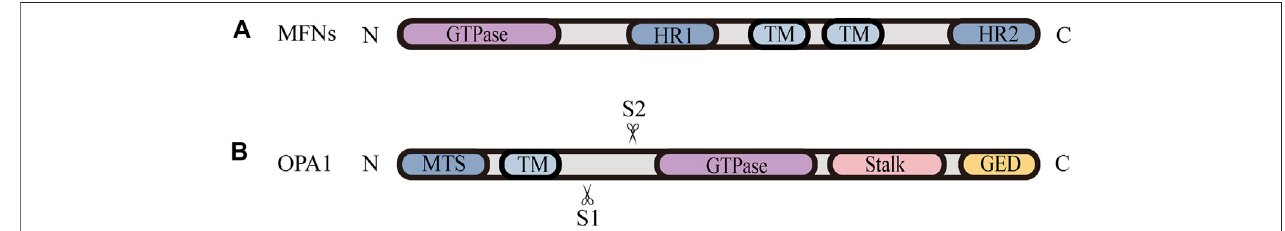
FIGURE 2 | Schematic diagrams of the structural elements of fusion proteins. (A) The MFNs contains two TM domains, separated by a short loop, exposing the N-terminal region harbouring the GTPase and HR1 domain, and the C-terminal containing the HR2 domain. (B) The structure of unprocessed OPA1 includes the N-terminalMTS, TMdomain,GTPase domain, middle stalkregion, and the C-terminus containingtheGED. OPA1can beproteolyticallyprocessed byYME1Lor OMA1 at S1 or S2, respectively, leading to the accumulation of L-OPA1 or